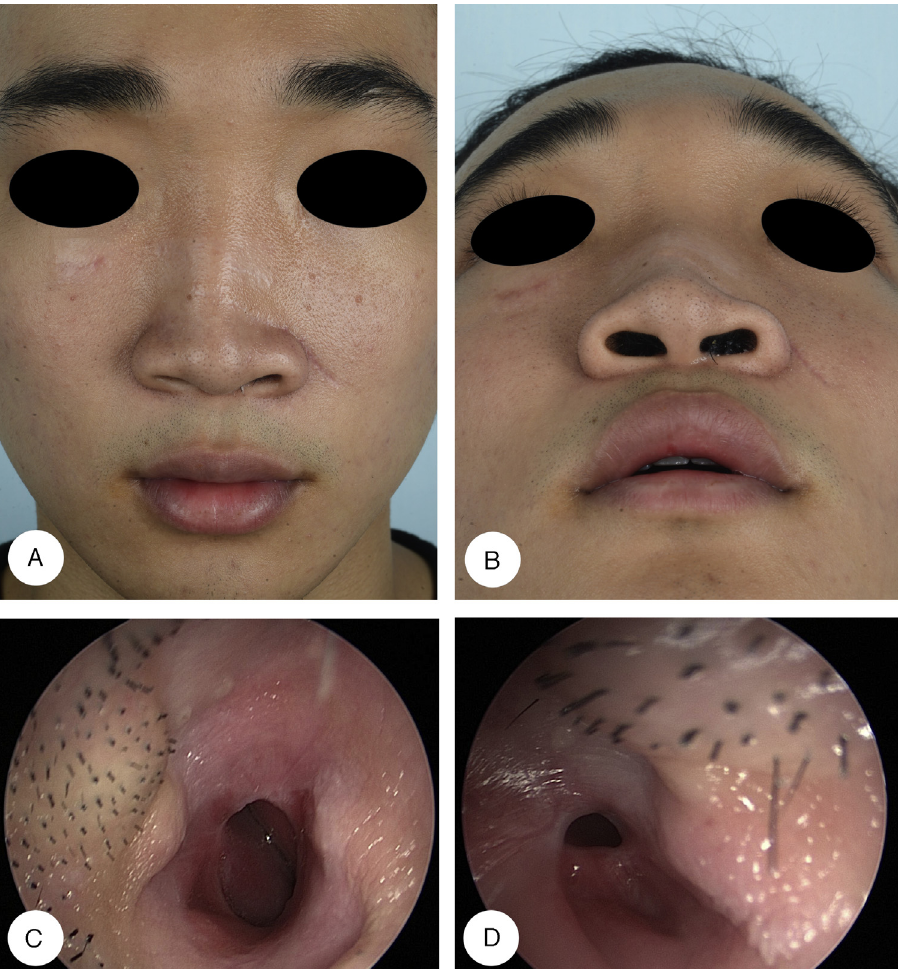
Figure 1 Preoperative profiles and endoscopic findings. Frontal (A) and basal (B) views show linear scars in the nasal dorsum and collapse of the left nasal alar cartilage. Nasal endoscopy shows vestibular stenosis obscuring about 70% and 90% of the right (C) and left (D) nasal vestibule,